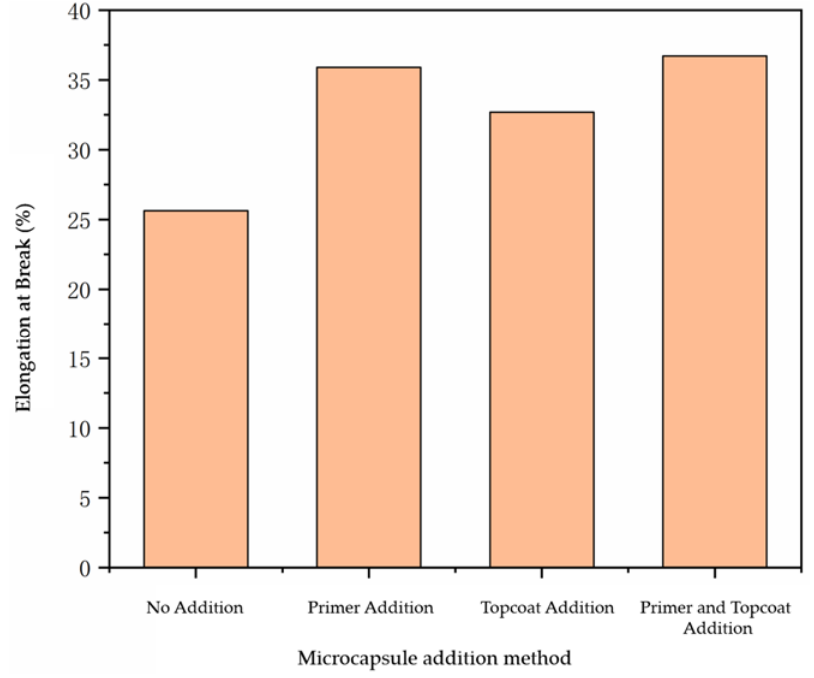
Figure 4. Influence of additive methods on the elongation at break of paint film.